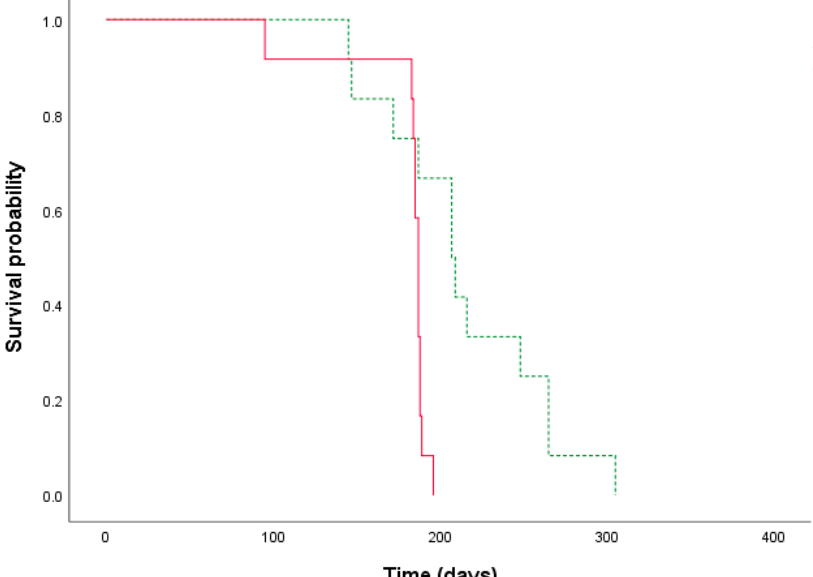
Figure 2. Survival analysis on COVID-19 cases after vaccination.